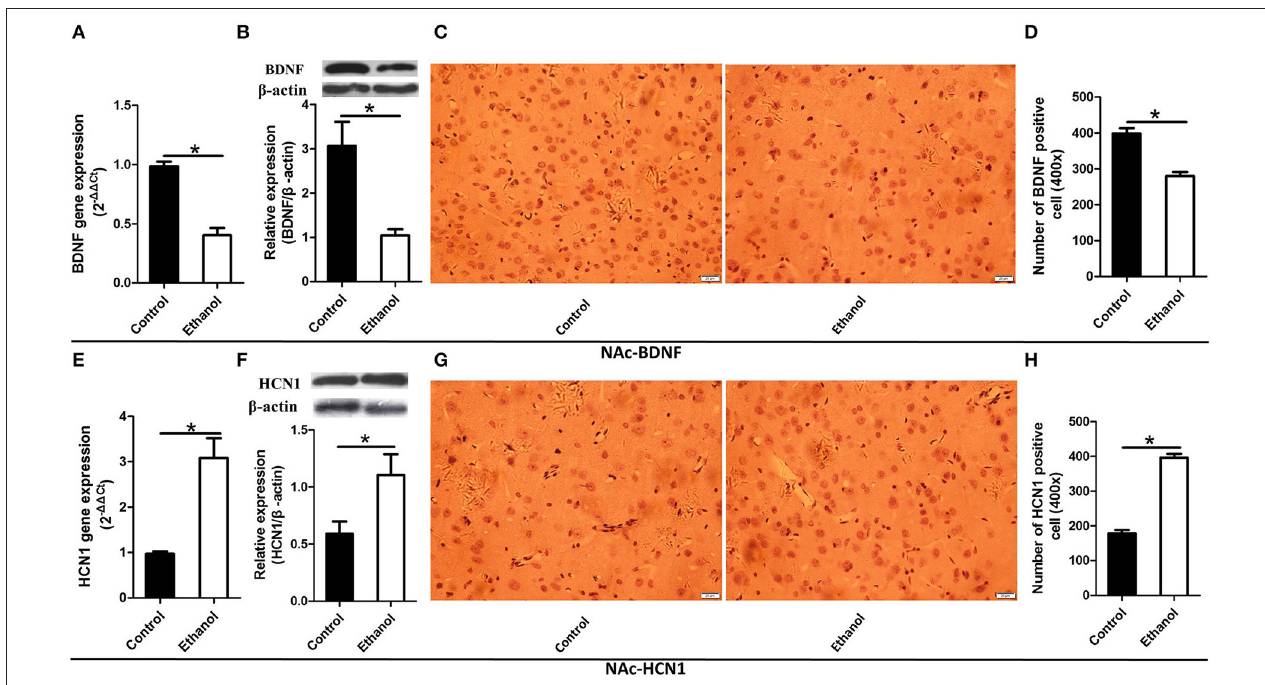
FIGURE 5 | Effects of the ethanol withdrawal procedure on the hyperpolarization-activated cyclic nucleotide-gated cation channel (HCN1) and brain-derived neurotrophic factor (BDNF) protein or gene level changes in the nucleus accumbens (NAc). (A) The expression of BDNF BDNF mRNA in the NAc. (B) The expression of BDNF-positive cells in the NAc. (C) Expression of BDNF positive cells in the NAc. (D) The number of BDNF-positive cells in the Hip. (E) The expression of HCN1 mRNA in the NAc. (F) The expression of HCN1-positive cells in the NAc. (G) Expression of HCN1 positive cells in the NAc. (H) The number of HCN1-positive cells in the NAc. The BDNF- and HCN1-positive cells in the NAc are represented by photomicrographs (400 × ). Data are mean ± standard error. * P < 0.05 was